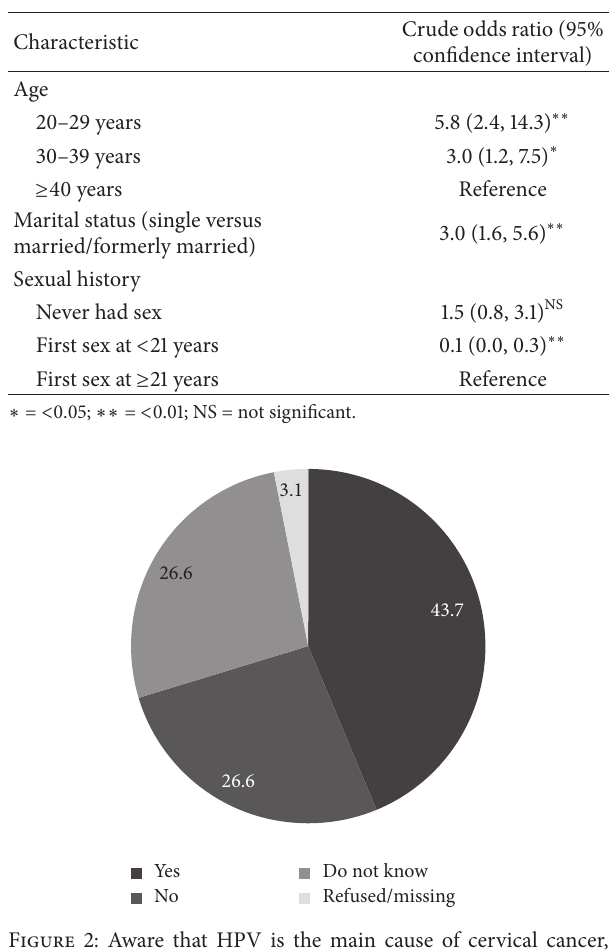
Table 3: Crude odds of having ever heard of HPV, Odisha, India ( 𝑛 = 286 ).